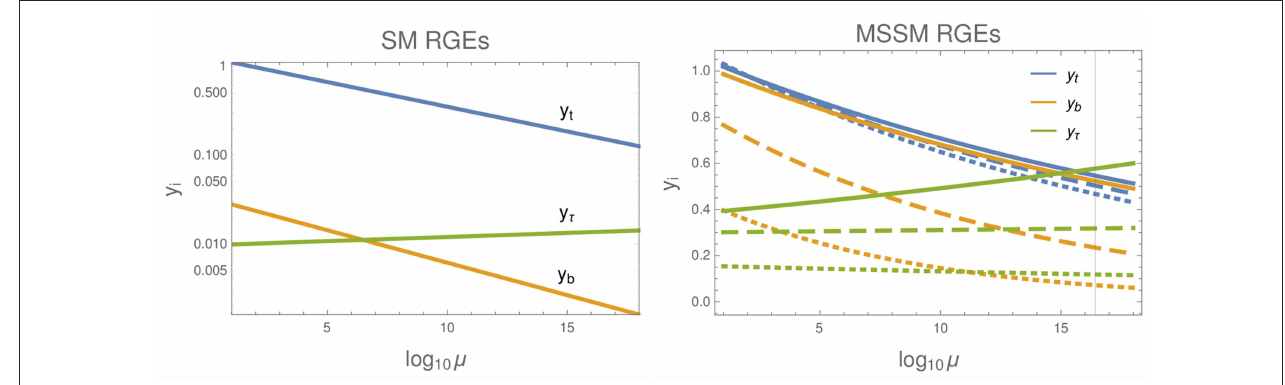
FIGURE 5 | One loop renormalisation group flow of the SM (left) and MSSM (right) Yukawa couplings, with m 0 (solid), tan β 30 (dashed) and tan β =